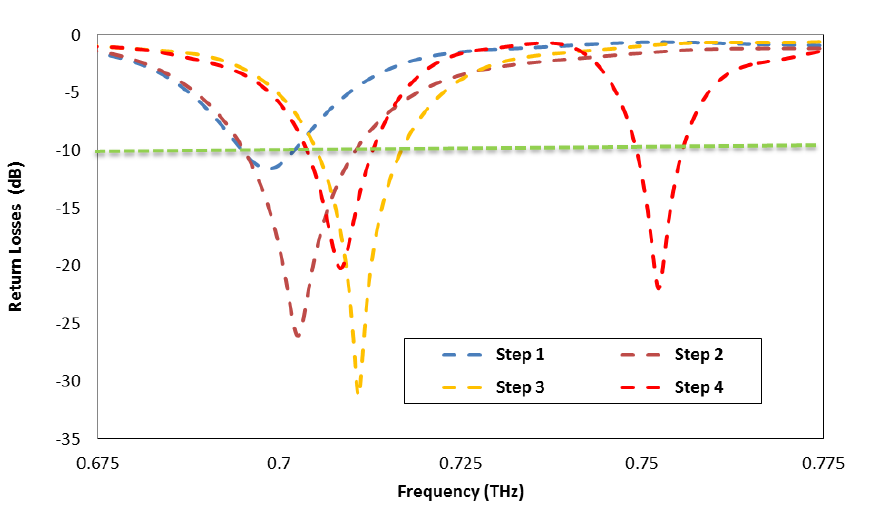
Figure 5. Evaluation of Type A/Step 4 antenna with the help of return loss vs. frequency graph.